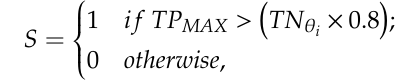
Table 4. Voting lookup table mechanism.